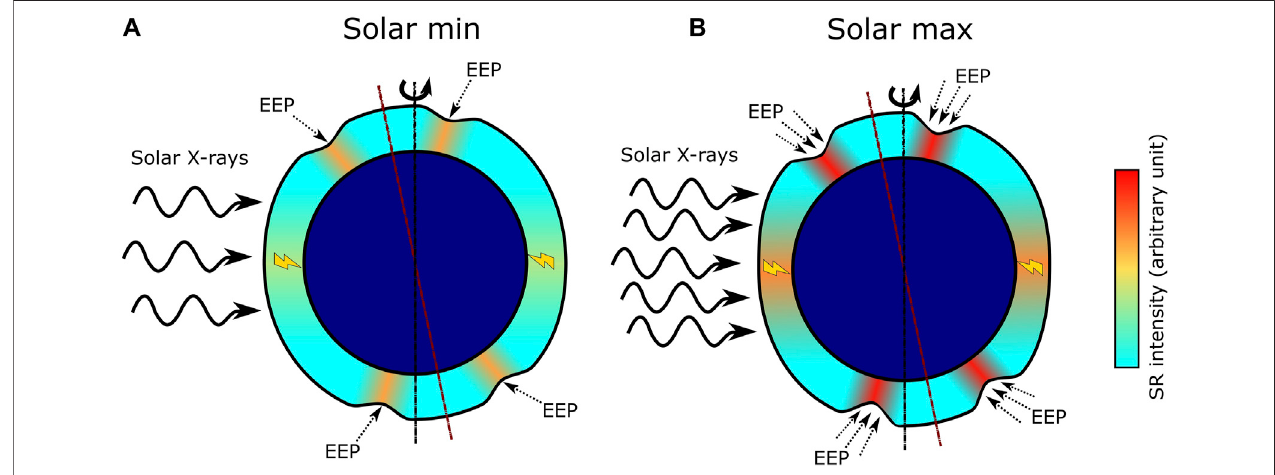
FIGURE 9 | Illustration of the deformation of the Earth – ionosphere cavity at solar minimum (A) and solar maximum (B) . At solar maximum X-rays and EEP reduce the cavity height more signi fi cantly (dominantly over low- and high latitudes, respectively) which results in enhanced SR intensity values beneath the deformed regions.